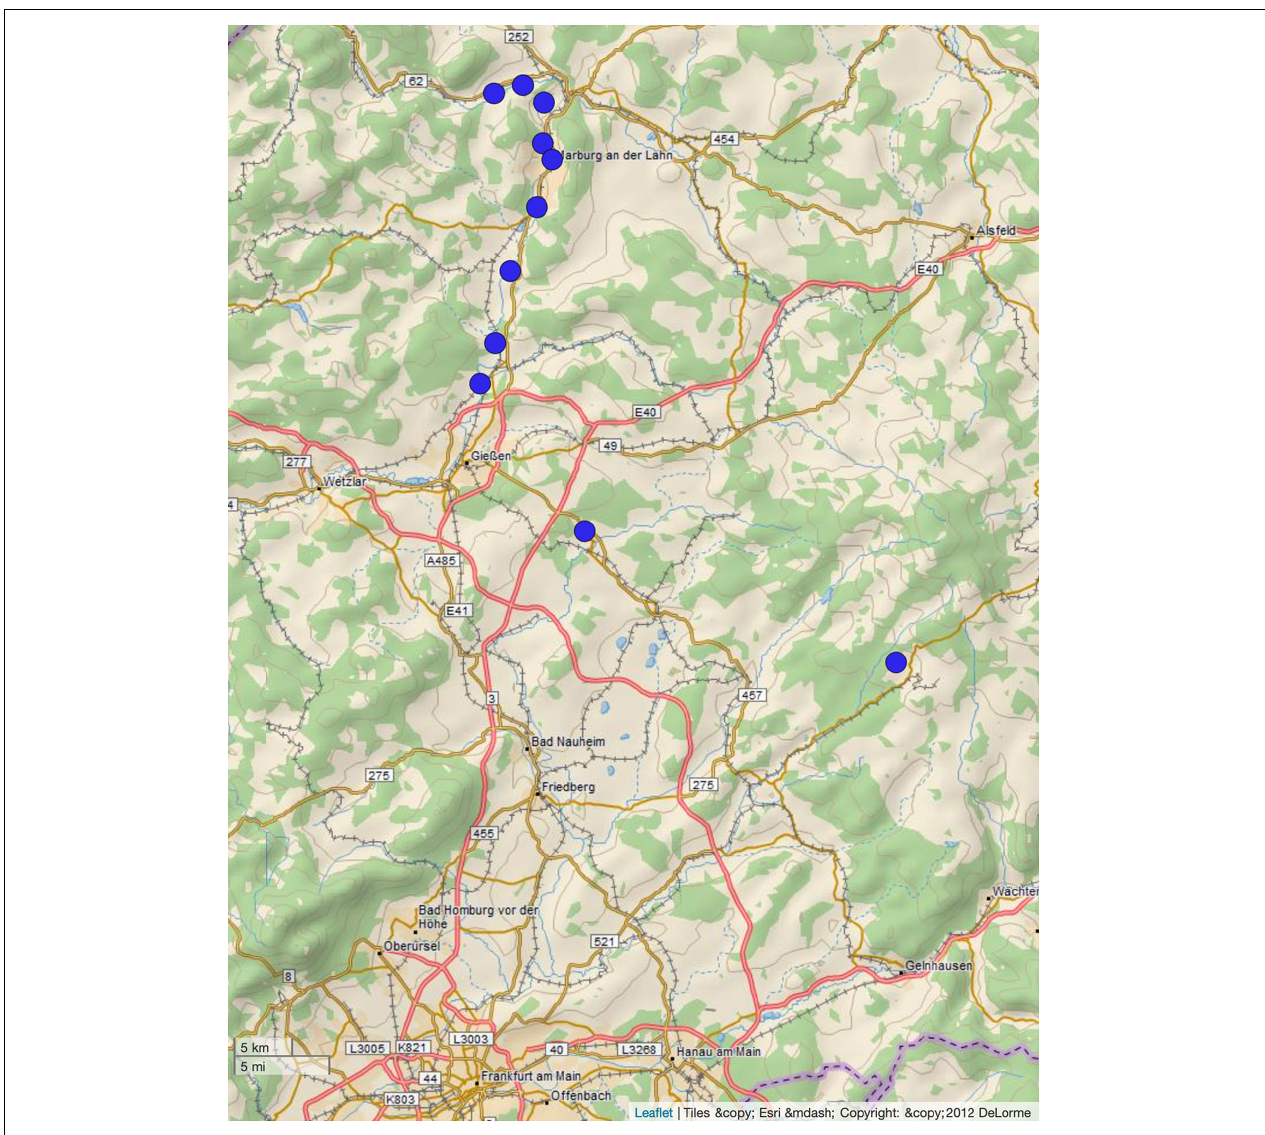
FIGURE 1 | Distribution of sampling sites. The figure was generated using microreact (Argimón et al.,